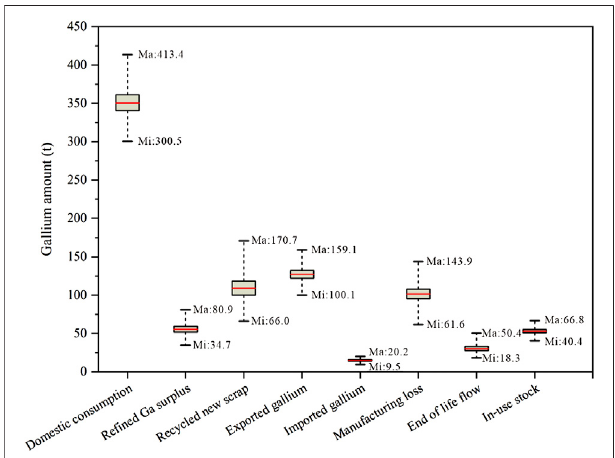
FIGURE10| ResultsofuncertaintyevaluationforChina ’ sgalliumcyclein 2020. (Top line is the maximum value (Ma); bottom line is the minimum value (Mi);boxtopisthethirdquartile;boxbottomisthe fi rstquartile;thickredlinein center of the box is the data